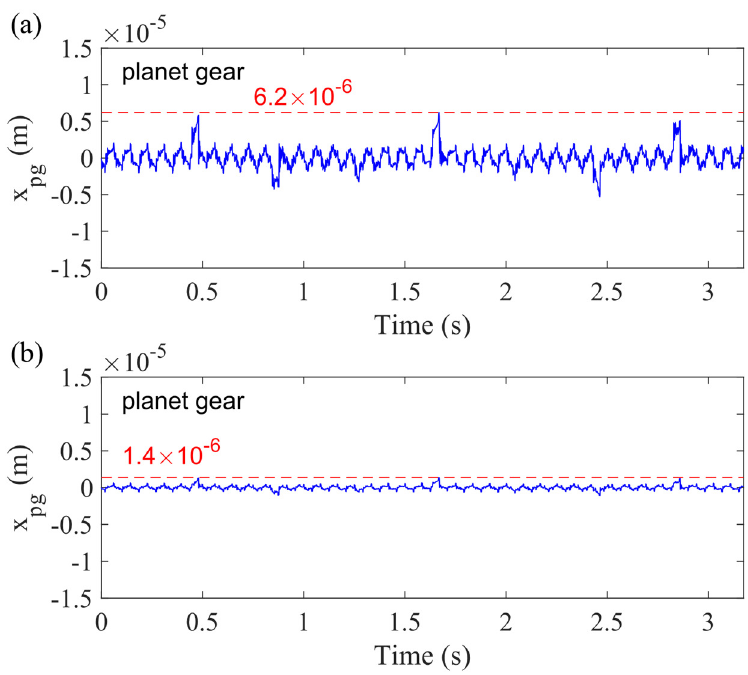
Figure 19. Vibration response of planet gear with 50% sun gear crack level considering ( a ) no and ( b ) sun gear and carrier bearing clearance in x g -direction.